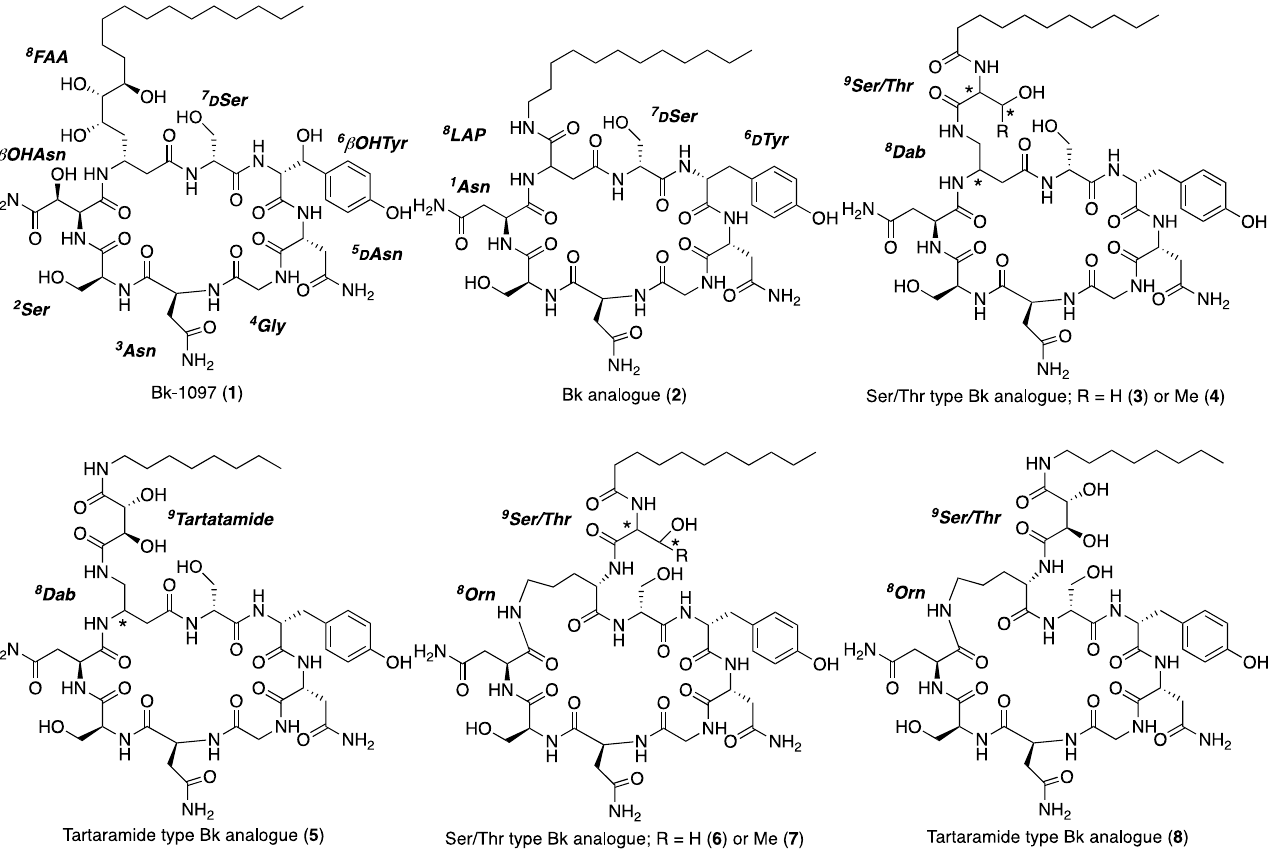
Figure 1. Bk-1097 ( 1 ) and Bk-1097 analogues ( 2 – 8 ).